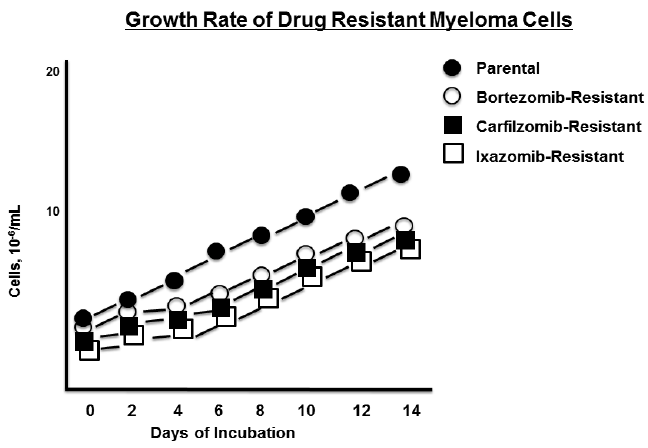
Figure 2. Growth rate of drug ‐ resistant myeloma cells. The growth rate of parental and drug ‐ resistant cells was determined by counting live cells by trypan blue staining. Shown is the average of triplicate measurements.